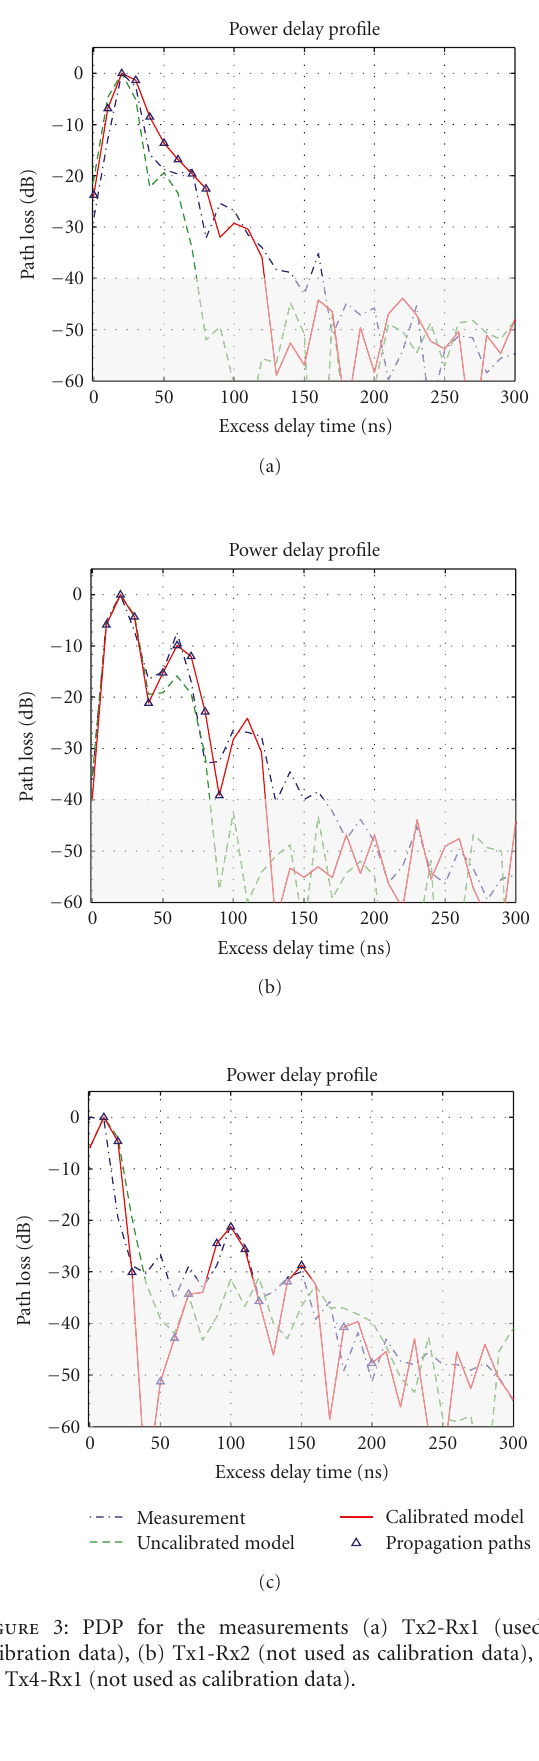
Figure 3: PDP for the measurements (a) Tx2-Rx1 (used as calibration data), (b) Tx1-Rx2 (not used as calibration data), and (c) Tx4-Rx1 (not used as calibration data).